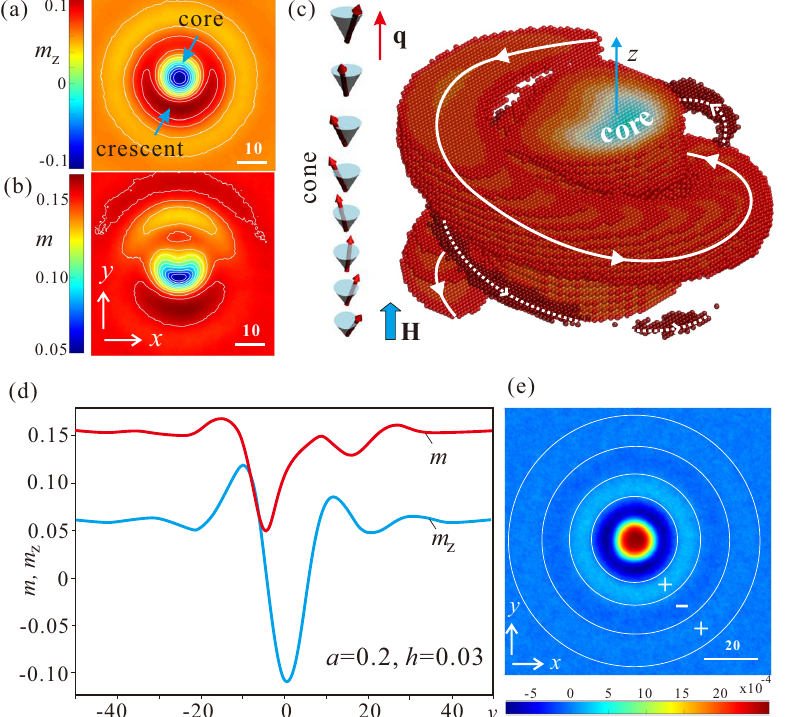
Figure 4. (color online) Magnetic structure of nonaxisymmetric skyrmions within the conical phase of bulk cubic helimagnets near the ordering temperature. Color plots of the out-of-plane magnetic moment, m z ( x , y ) ( a ), and the modulus, m ( x , y ) ( b ), plotted for one cross-section with the fixed coordinate z . In ( c ), an alternative way of representing the internal structure of a nonaxisymmetric skyrmion is used. After the magnetization components corresponding to the conical phase have been extracted, the 3D-model of the modulus m represents a cylinder-like core centered around the magnetization opposite to the field and exhibiting some reduced value and two coils with the magnetization along the field and enhanced modulus value. ( d ) two-dimensional cross-cuts across the skyrmion center exhibiting distributions m z ( y ) and m ( y ) . After averaging over all energy profiles within one conical period, the energy distribution ( e ) exhibits the following composite parts: the core with the positive energy density, the ring with the negative energy density, and a number of additional rings with alternating energy